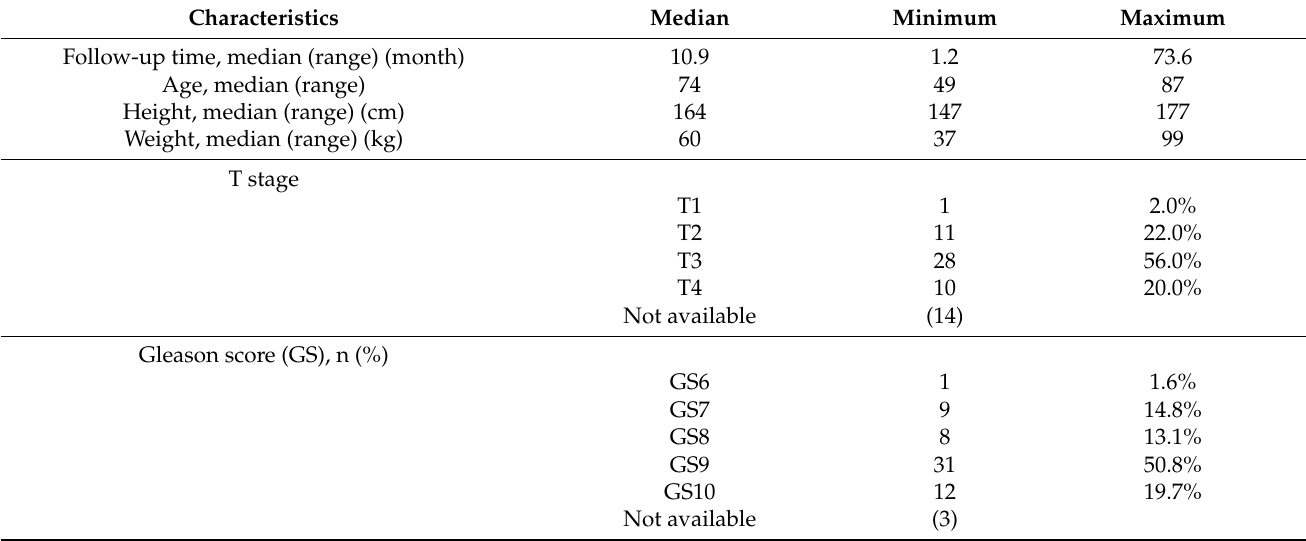
Table 1. Characteristics of